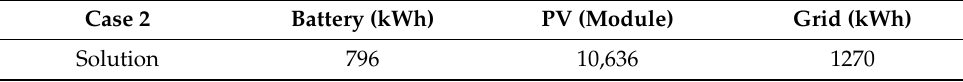
Table 3. Solution of Case 2.